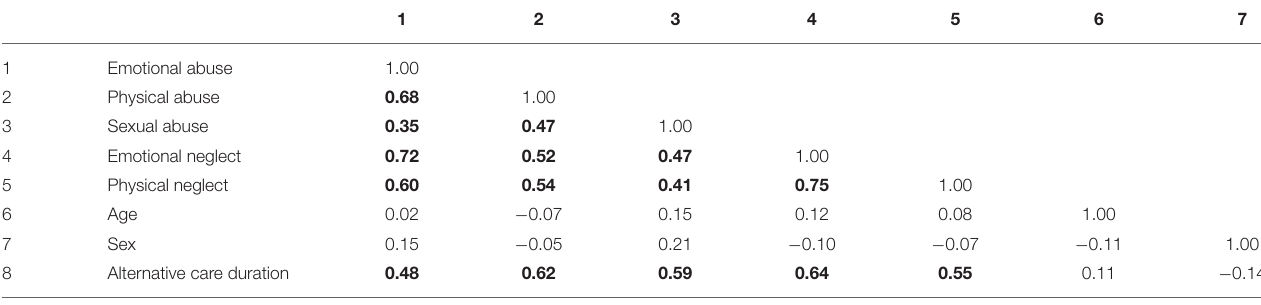
TABLE 2 | Spearman correlation coefficients of maltreatment types and demographics.